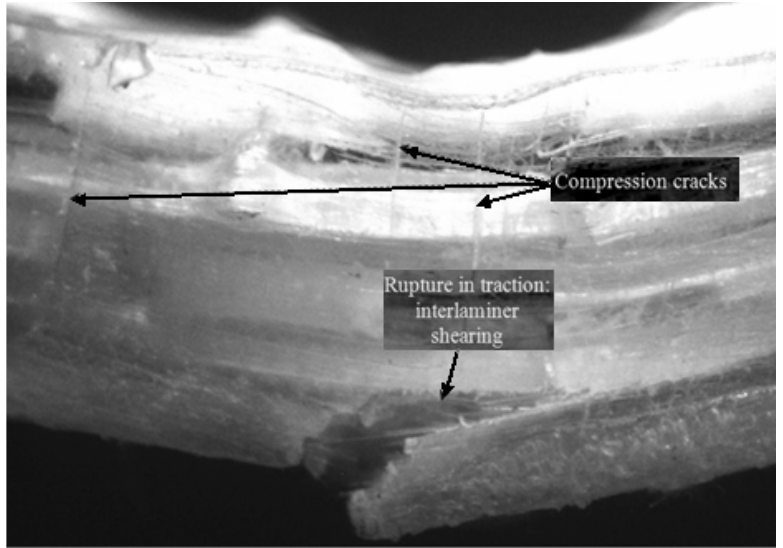
Figure 12. Transversal section of tested laminated composite